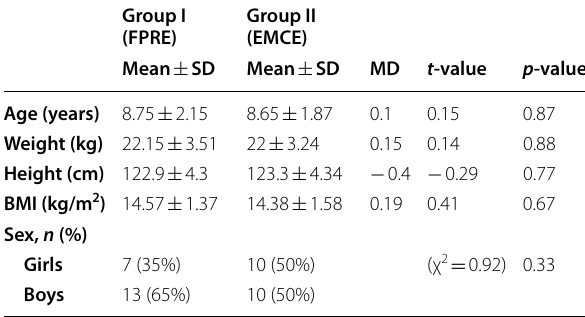
Table 1 Comparison of subject characteristics between groups I and